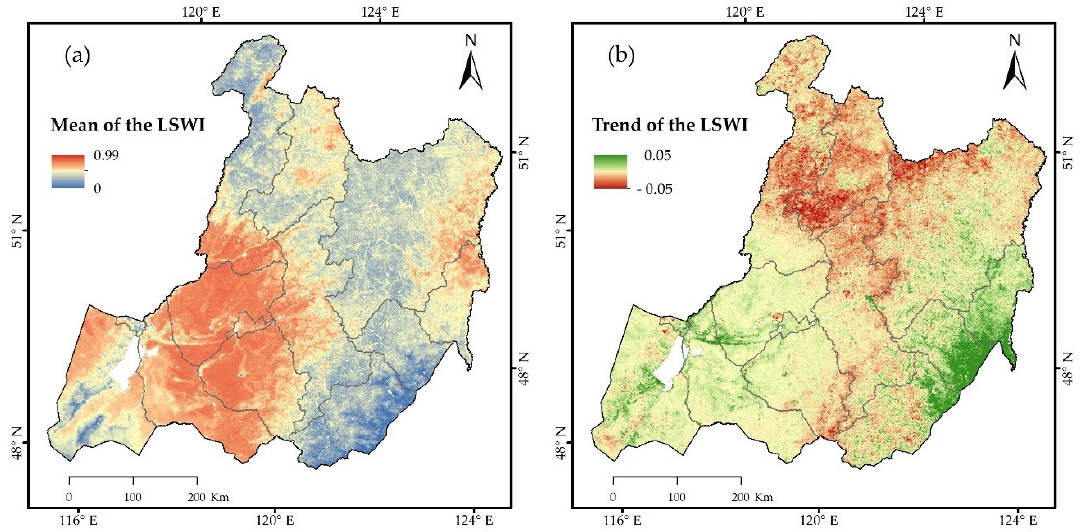
Figure 6. Distribution of ( a ) mean of Land Surface Water Index (LSWI) and ( b ) trend of LSWI in 2001–2018.